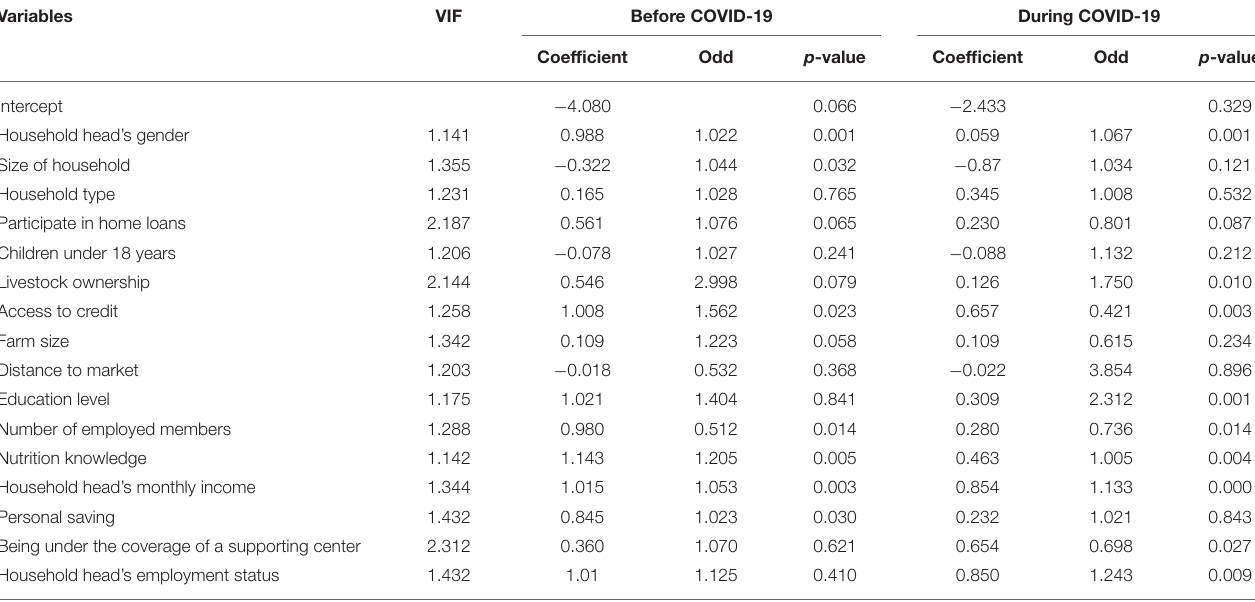
TABLE 6 | Factors associated with food security before and during COVID-19 using multinomial regression.